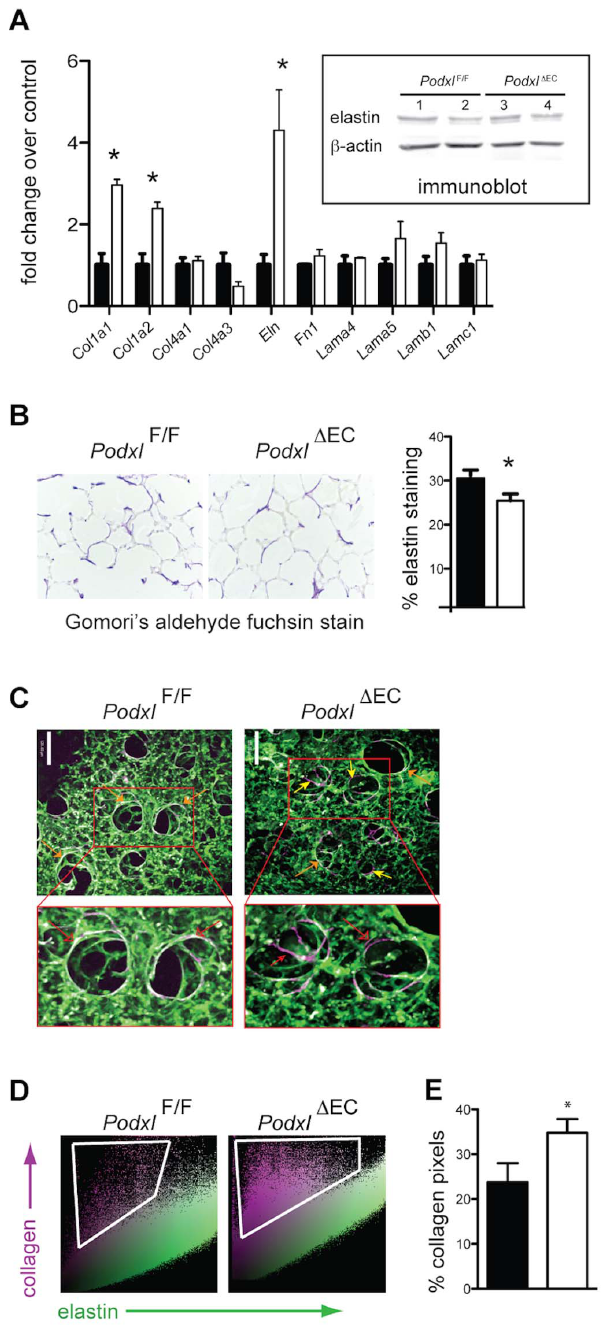
Figure 5. Podocalyxin deletion results in altered matrix deposition in the lung. ( A ) Whole lung tissue from Podxl F/F (black bars) and Podxl D EC (white bars) mice was assessed for expression of matrix related transcripts by qRT-PCR (n=3 mice per group) and for tropoelastin protein by Western blot (inset). Immunoblot lanes are from whole lung tissue lysates and each lane is a sample of lung